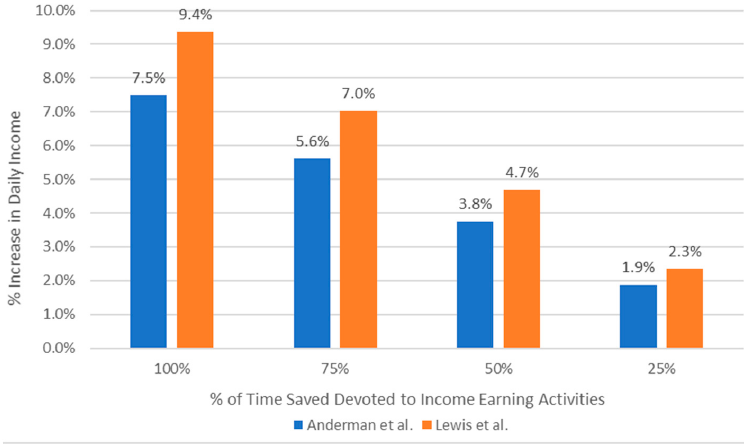
Figure 2. Potential increase in income by percentage of time devoted to income earning. This chart shows the potential percentage increase in income ( y axis) a user in each study could potentially earn by the amount of time saved devoted to income-earning activities ( x axis). Time is valued at 50% of local after-tax wages for each study.